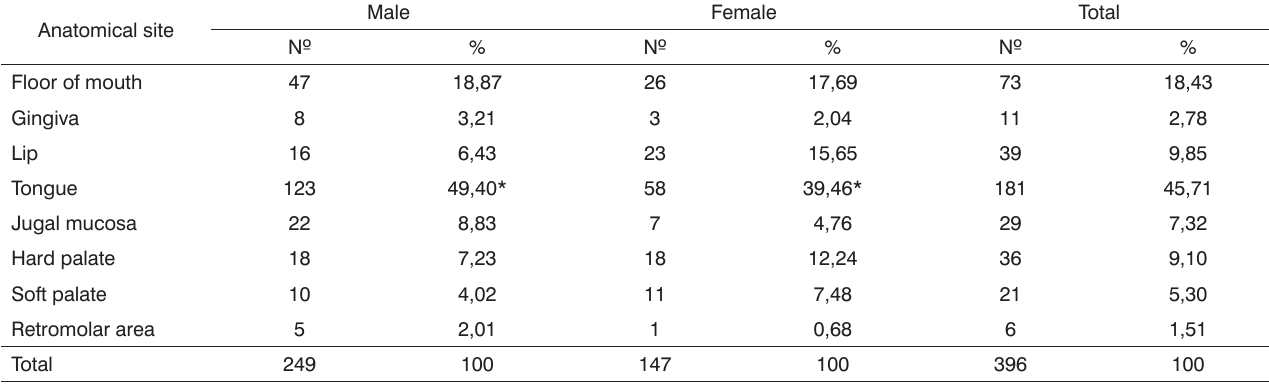
Table 2. Distribution of mouth squamous cell carcinoma patients according to the anatomical site Maceio-AL, 2000-2006.